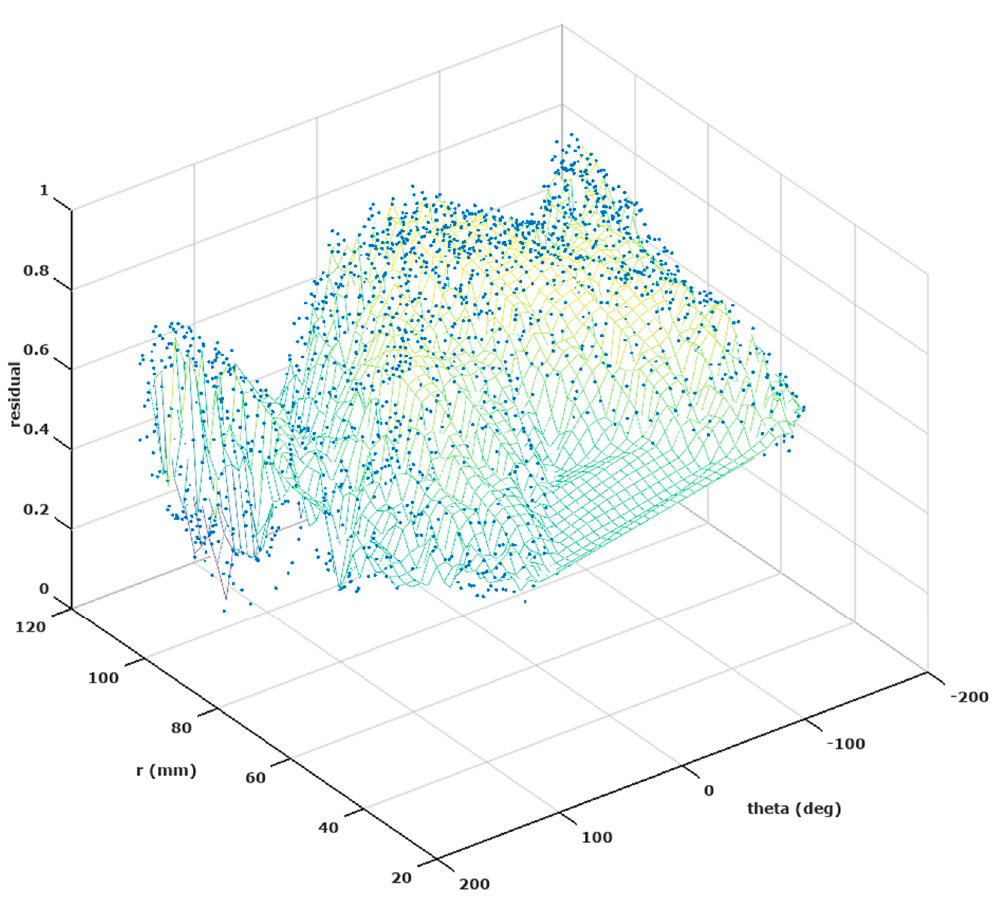
Figure 9. Residual at all candidate sources for an illustrative noise-free case in the realistic head model.